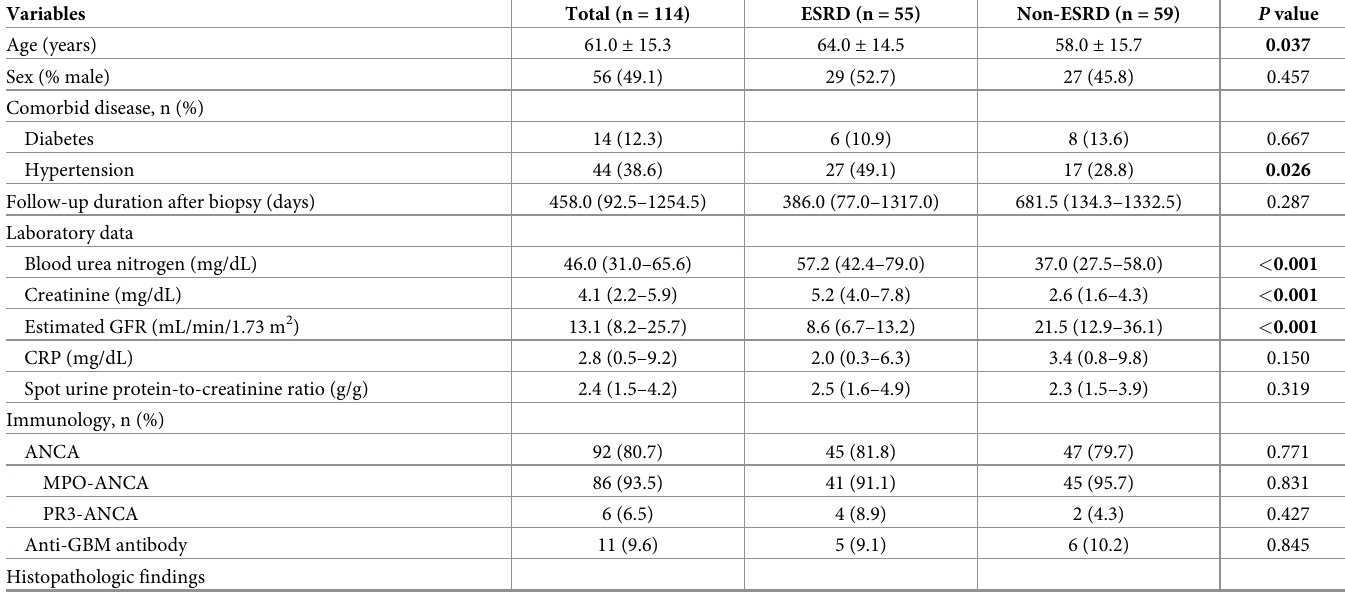
Table 1. Baseline clinical and histopathologic